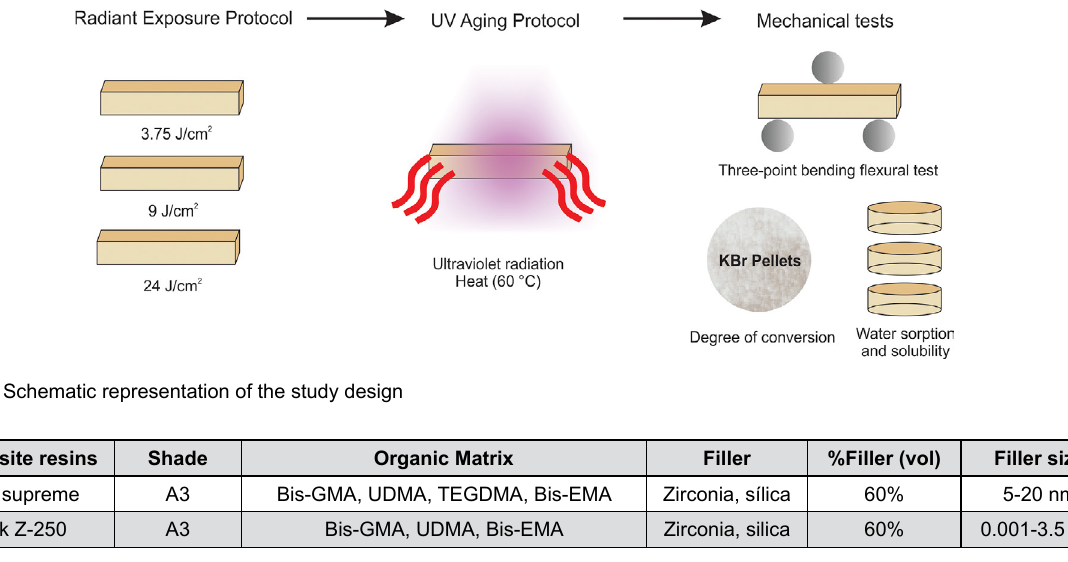
Figure 2- Constitution of the composite resins used in this